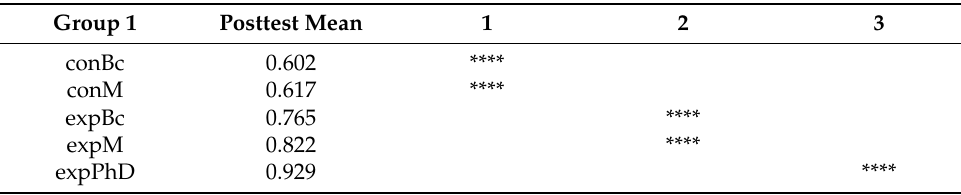
Table 9. Multiple comparisons taking into account the degree of study.